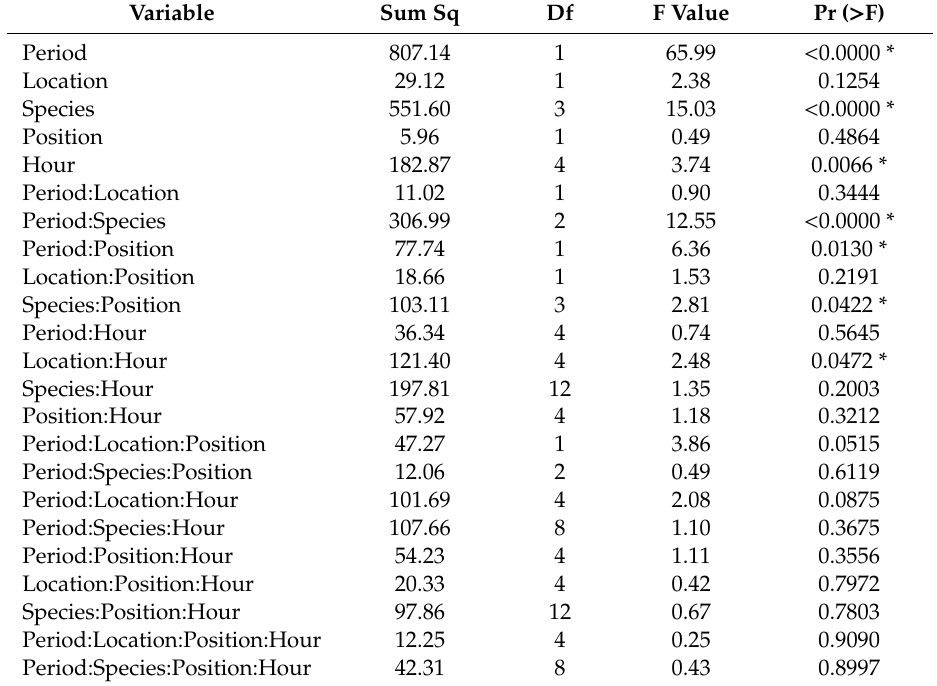
Table 2. ANOVA table for linear model of human biting rates as a function of periods before and during dam construction, location, species and biting position (indoor or outdoor), with their